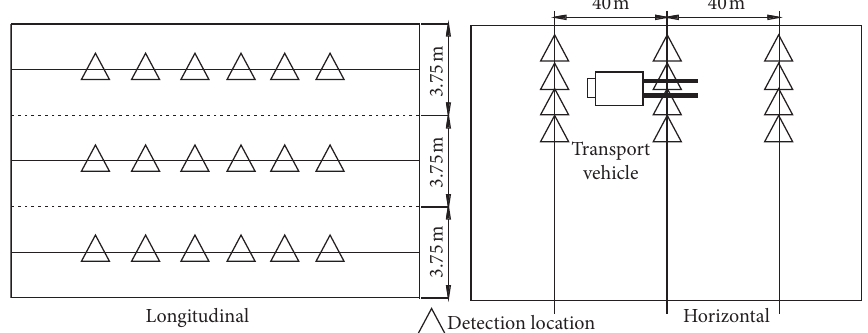
Figure 5: Schematic diagram of evenness